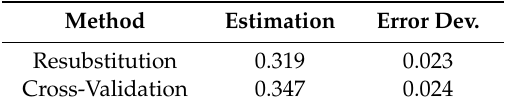
Table 4. Estimation risk for using Facebook (CHAID method).